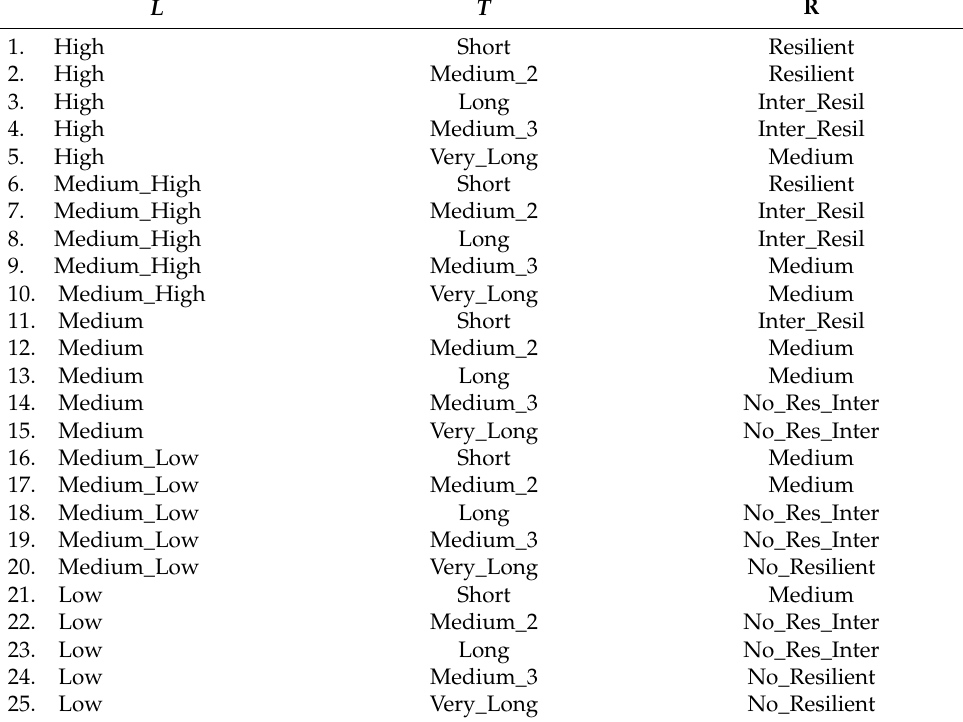
Table 9. Fuzzy rules using five linguistic terms for each